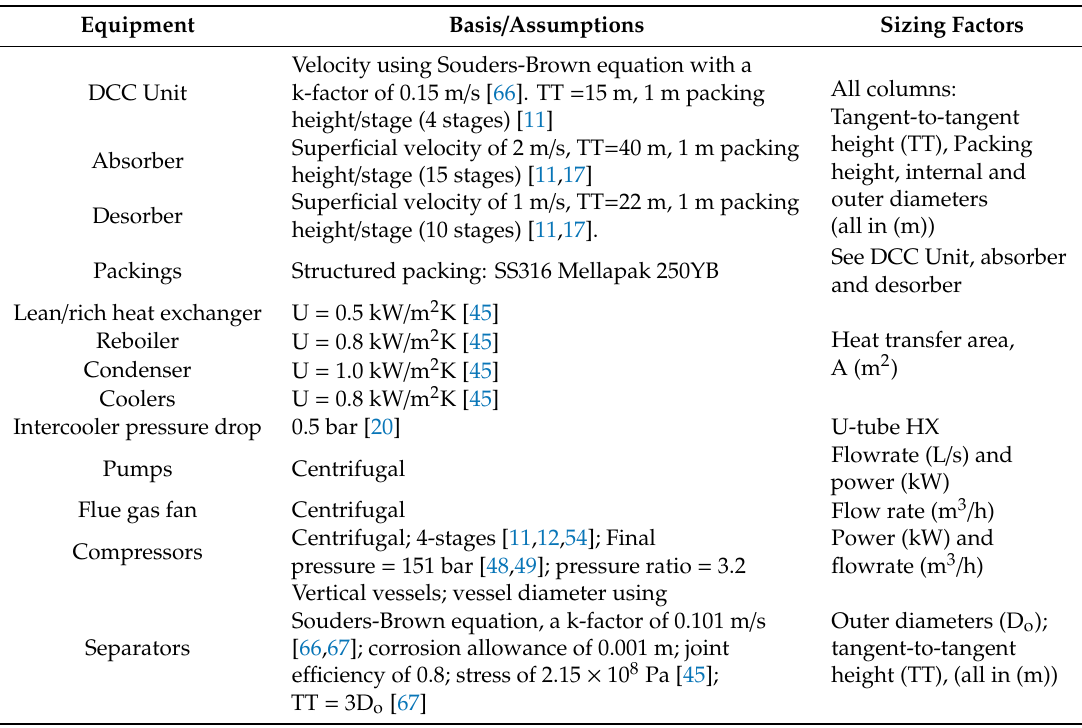
Table 2. Equipment dimensioning factors and